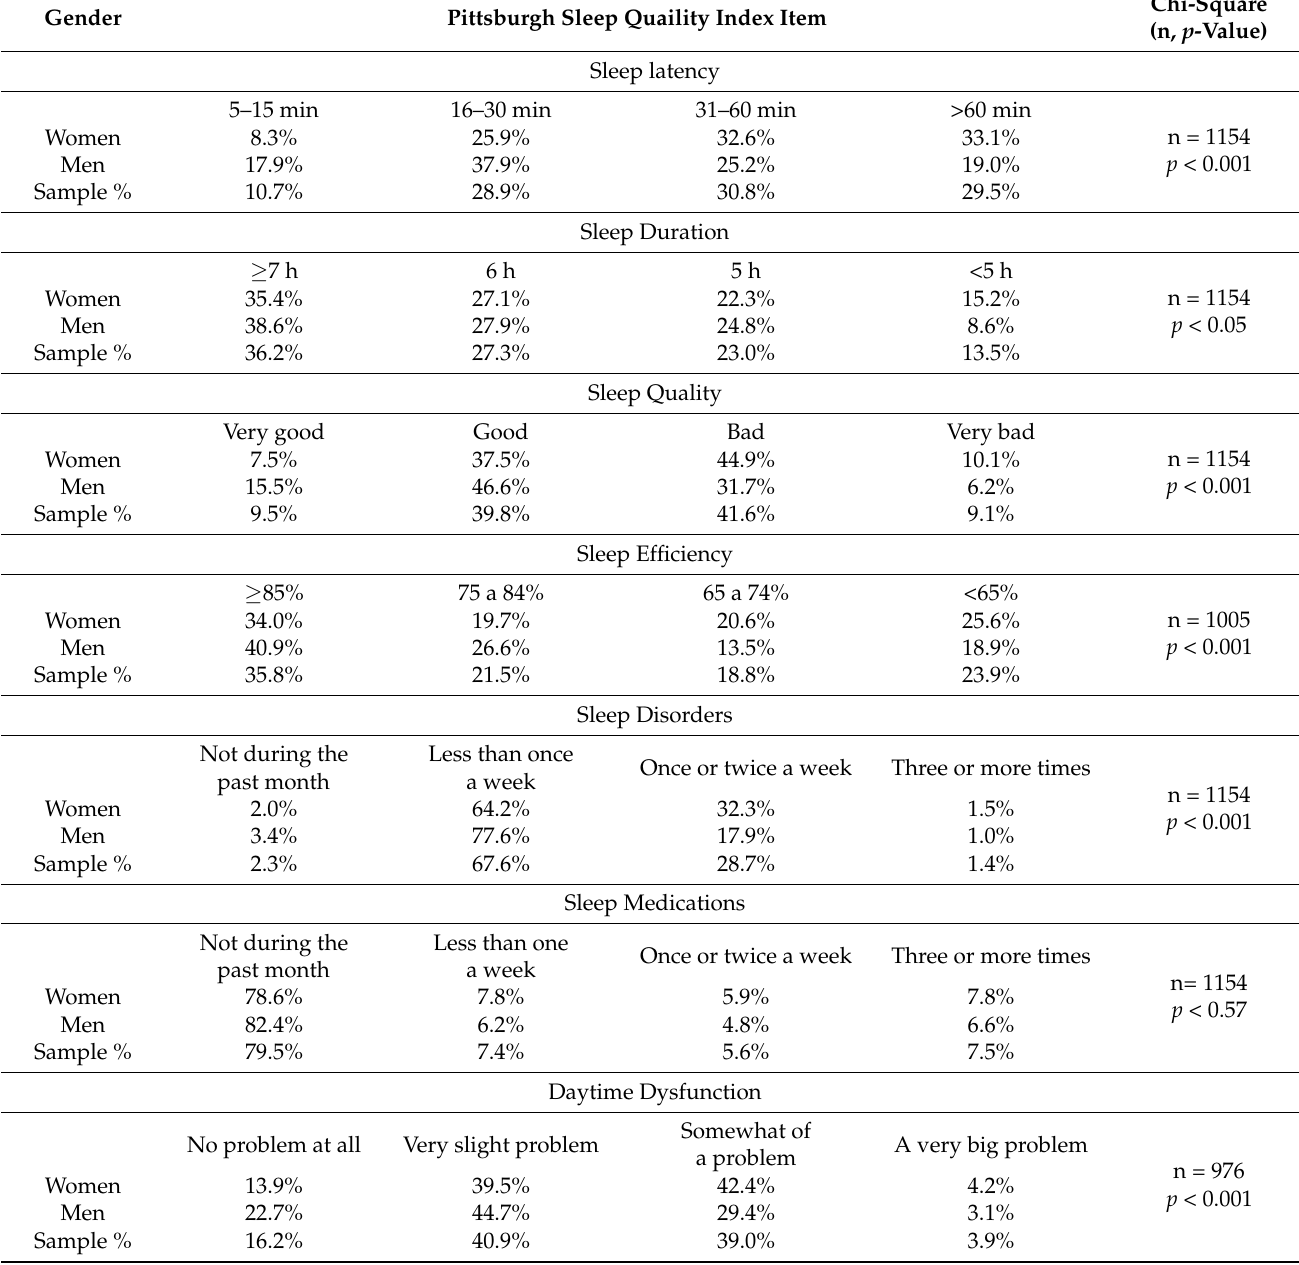
Table 1. Gender differences for the Pittsburgh Sleep Quality Index items according to the chi-square test